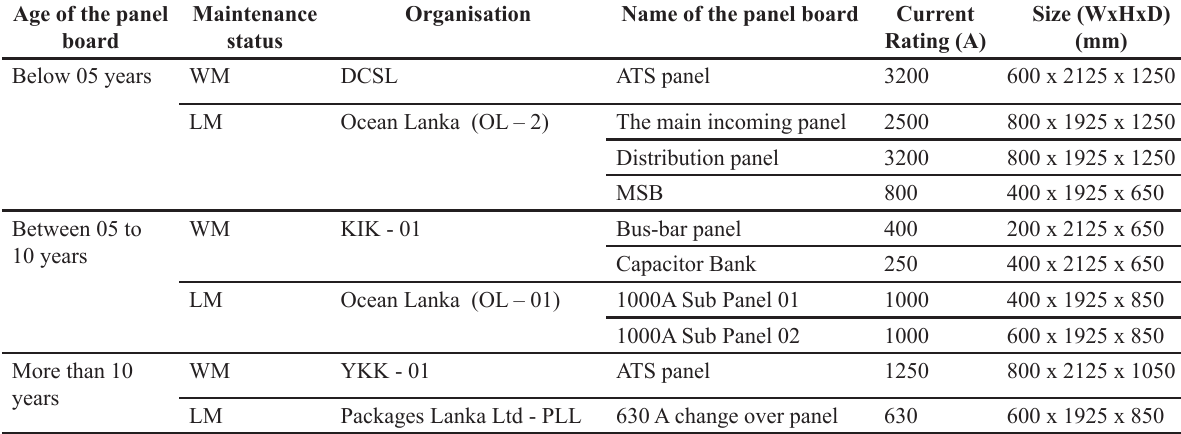
Table 1: Sample space for the field data collection Age of the